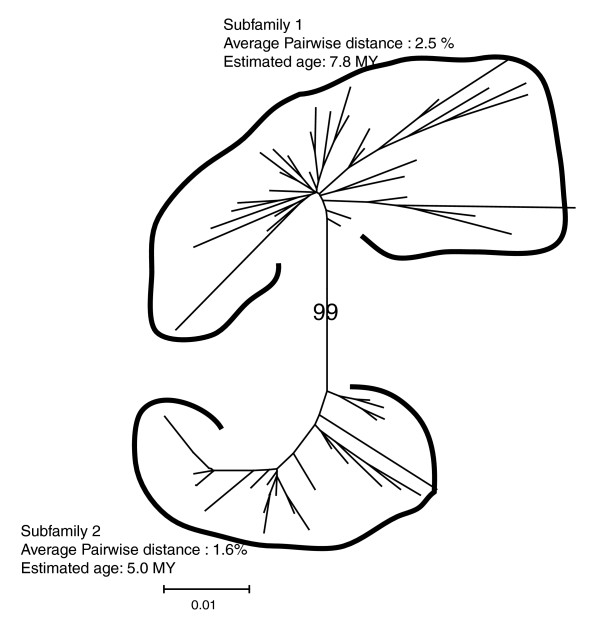
Phylogenetic tree of CERV 1/PTERV1 LTRs. Unrooted neighbor joining phylogenetic tree built from 5' and 3' LTRs from full-length CERV 1/PTERV1 elements. The average pairwise distances (corrected 'p' using Jukes-Cantor model) for each subfamily and the estimated ages are shown. Bootstrap values are shown.